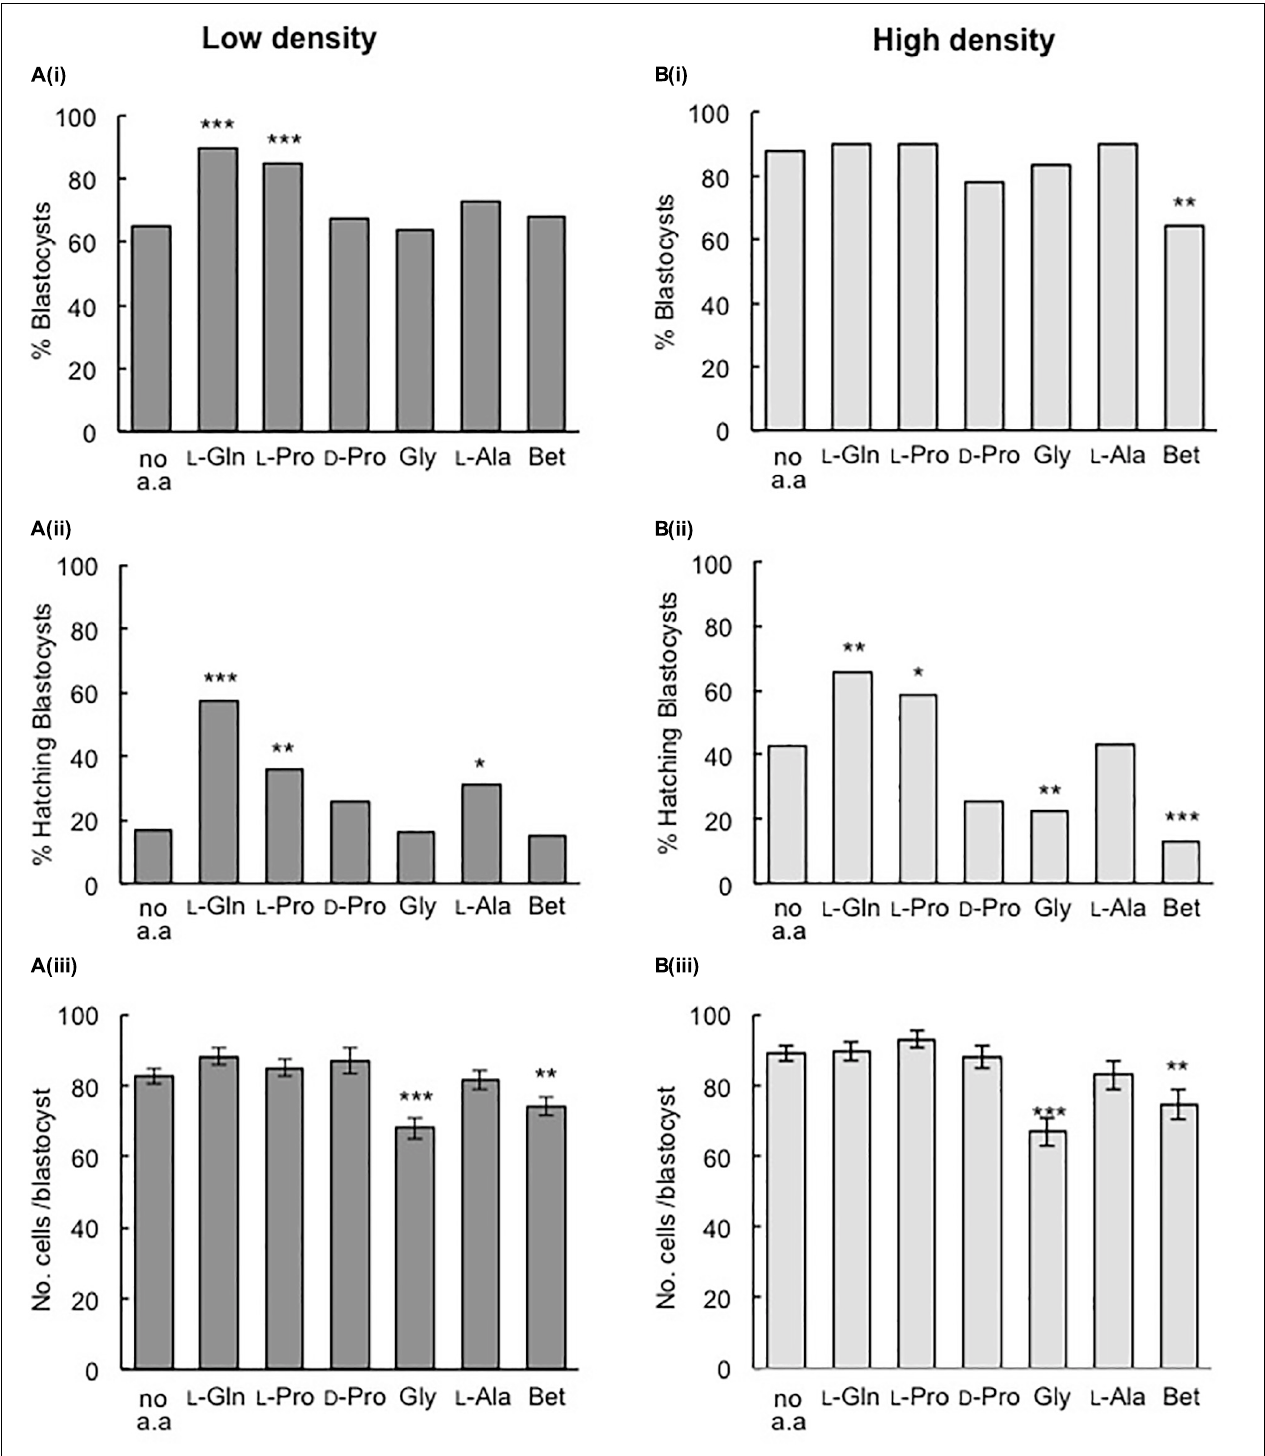
FIGURE 2 | Effect of individual amino acids on development of mouse embryos cultured in isosmotic (270 mOsm/kg) medium at LD (Ai–iii) and HD (Bi–iii). Zygotes (20–22 h post-hCG) were cultured for 5 days in the absence of amino acids (no a.a.) or in the presence of 1 mM L-Gln, 400 µ M L-Pro, 400 µ M D-Pro, 400 µ M Gly, 400 µ M L-Ala or 1 mM Betaine (Bet). (i) Percentage of zygotes that developed to the blastocyst stage. (ii) Percentage of hatching blastocysts. (iii) Cell numbers in blastocysts (mean ± SEM, n = 25–94). Embryos were analyzed from at least three independent biological replicates, each with at least 15 embryos per treatment. * P < 0.05; ** P < 0.01; *** P < 0.001 indicates significant differences from the no amino acid control, analyzed by either Chi-squared test (Ai,ii, Bi,ii) or one-way ANOVA with Dunnett’s post hoc test (Aiii, Biii) .